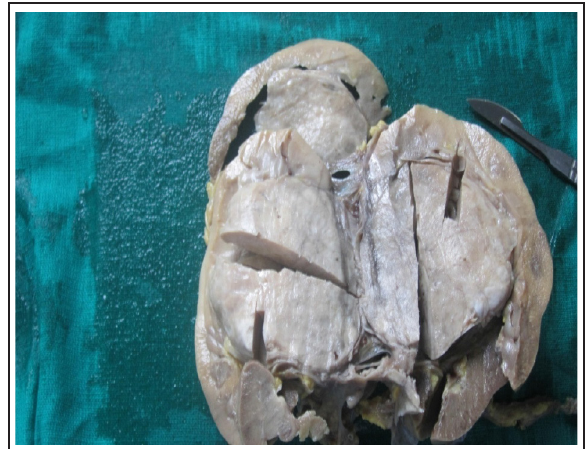
Figure 1. Gross finding of tumour.